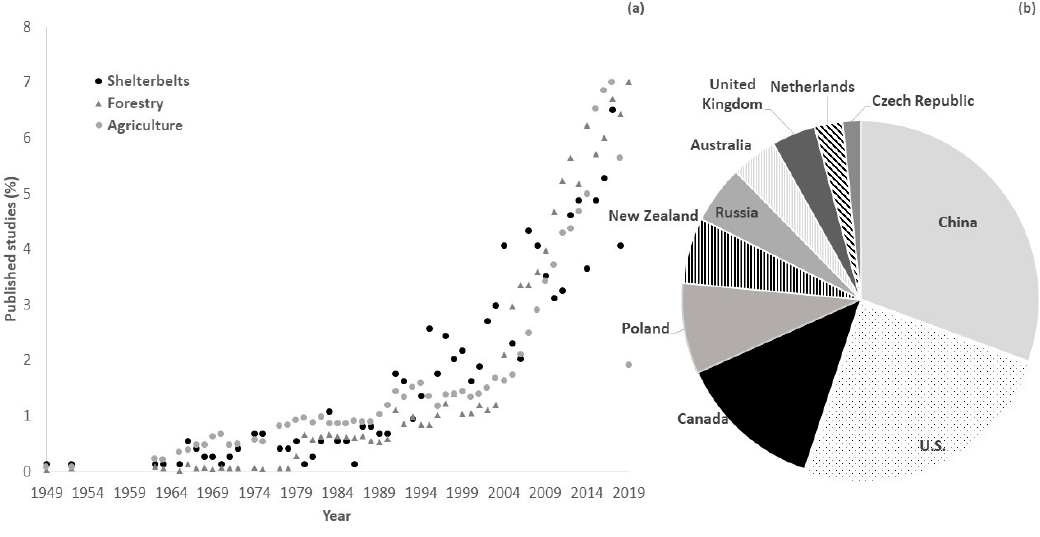
Figure 1. Number of journal publications on shelterbelt agroforestry systems found on Web of Science ( a ), and the relative contribution by country ( b ).